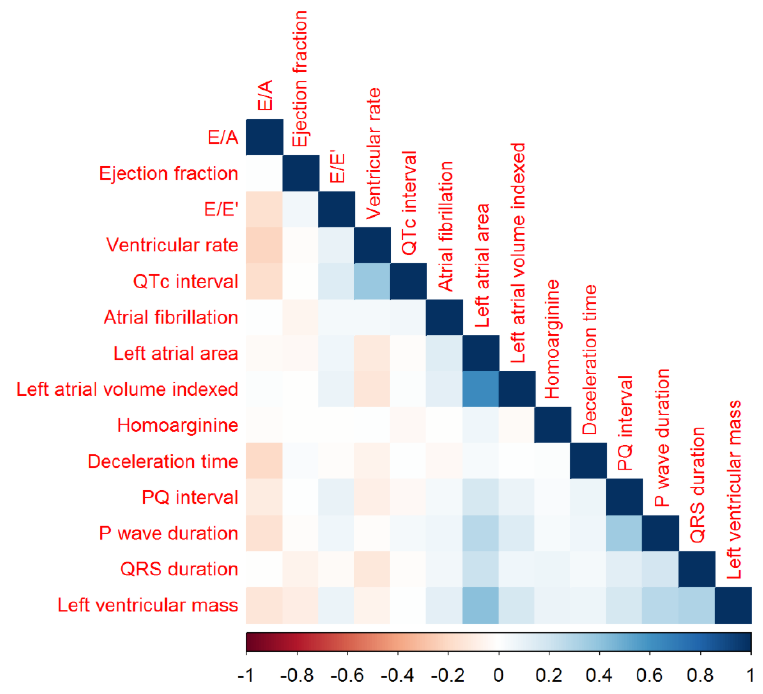
Figure 2. Kendall rank correlations between homoarginine, electrocardiographic and echocardiographic parameters, and atrial fibrillation (AF).